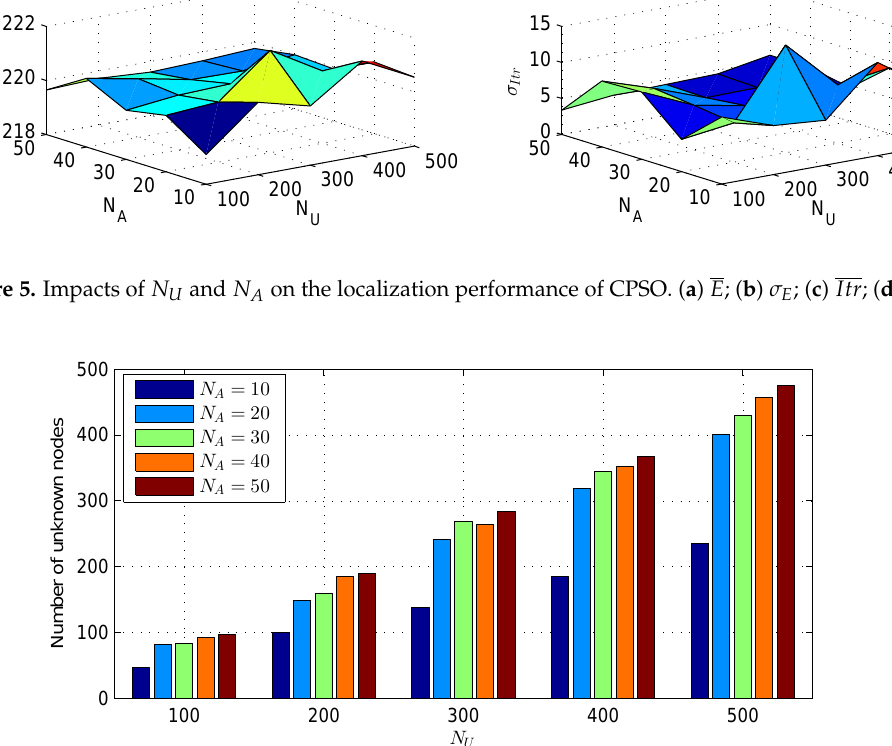
Figure 6. Number of unknown nodes localized by neighboring anchors under different N U and N A with